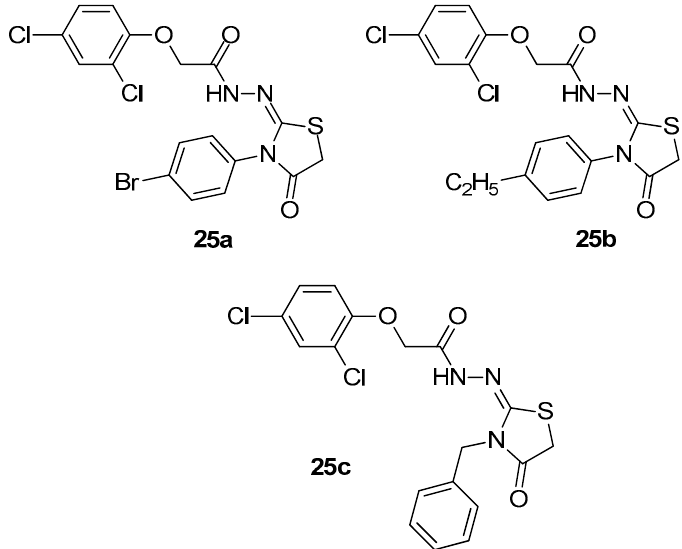
Figure 27. Chemical structures of 2-imino-4-thiazolidinone derivatives 25a – c .